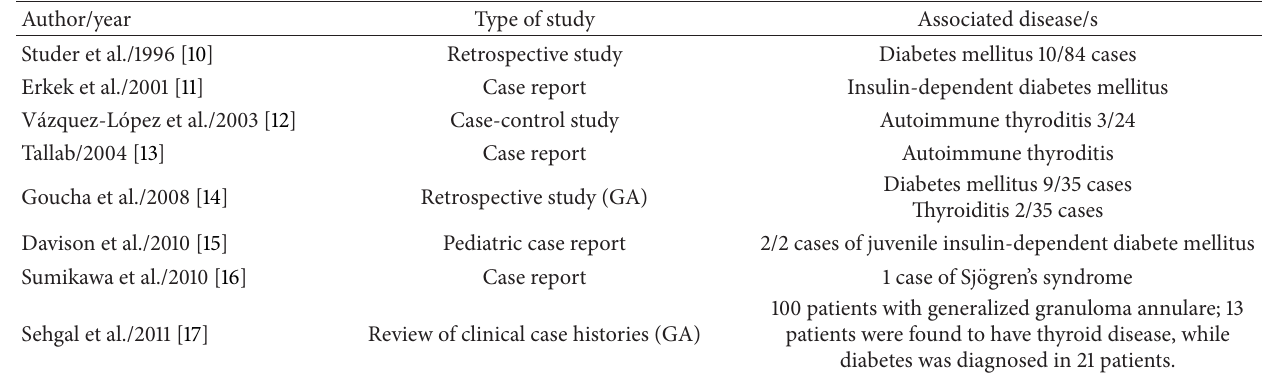
Table 1: Granulomatous diseases and autoimmune diseases